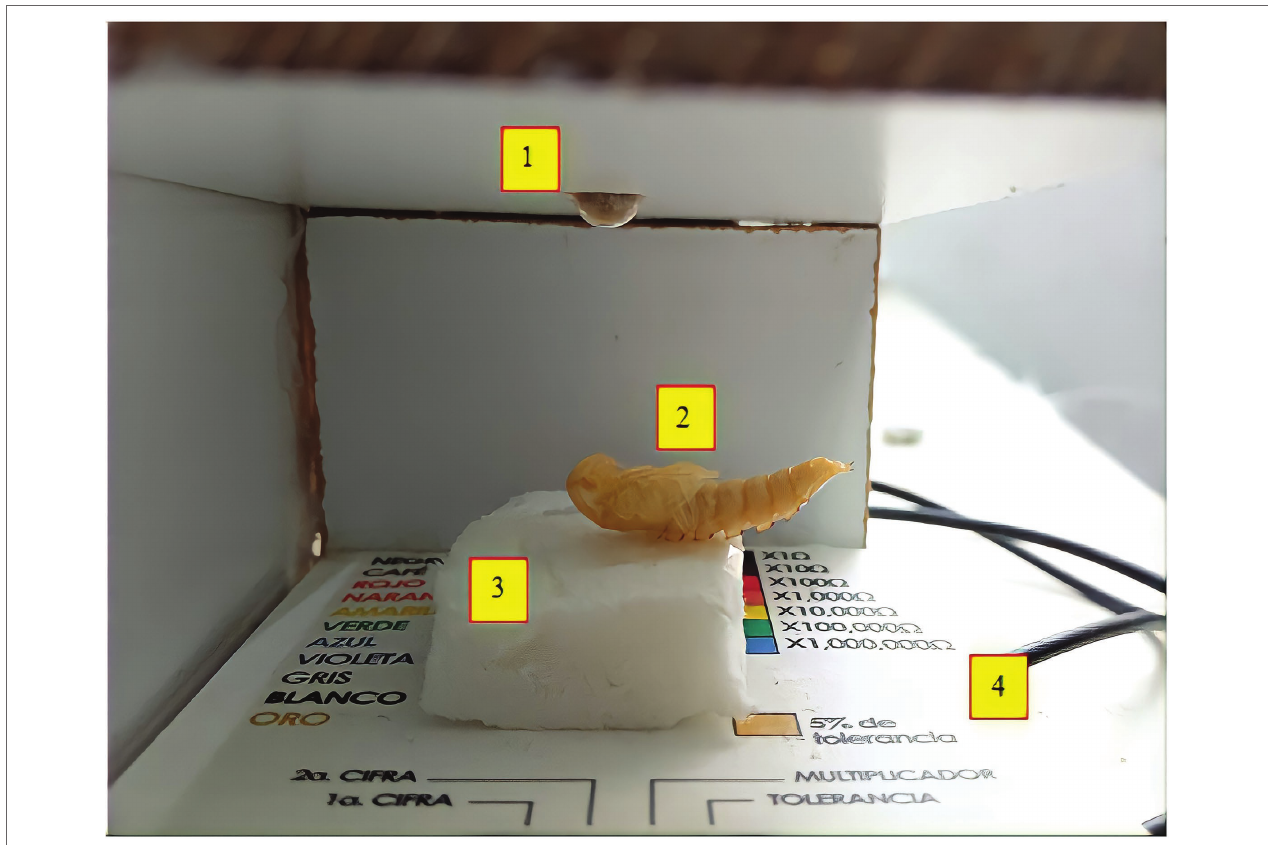
FIGURE 1 | Experimental chamber. 1 = LED lights, 2 = pupae, 3 = foam platform, and 4 = mini vibrating